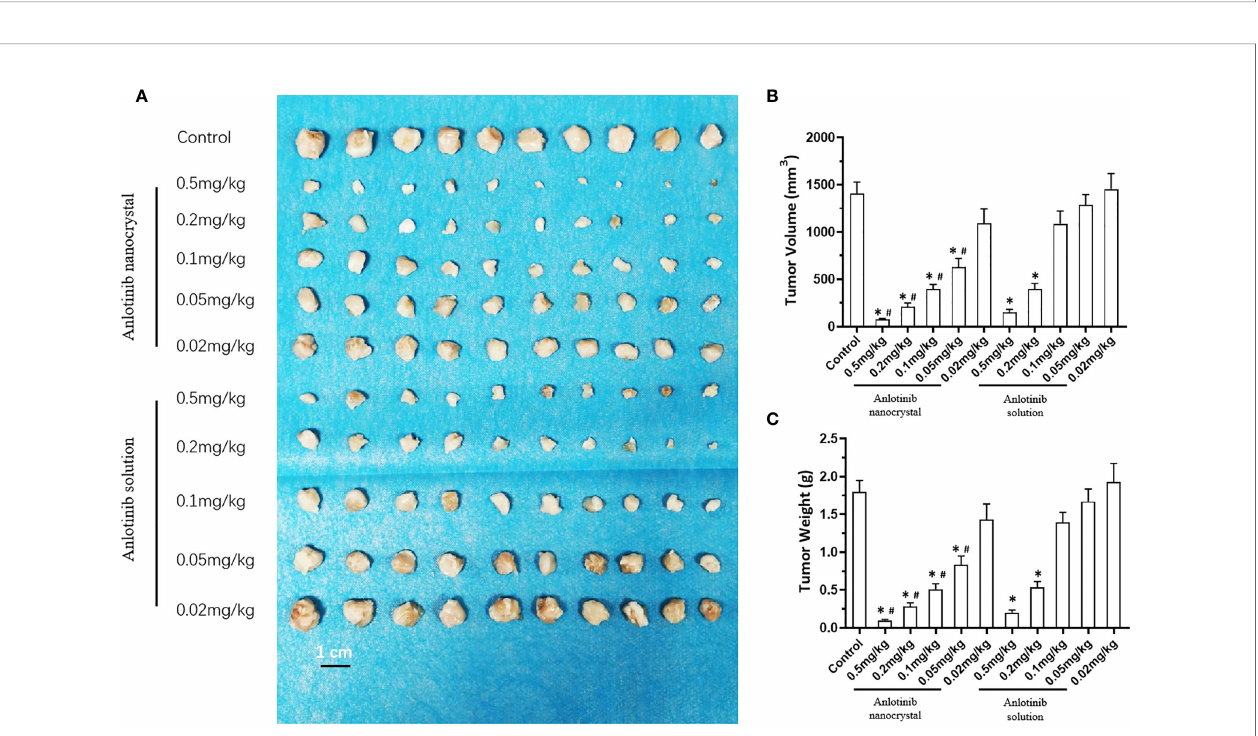
FIGURE 5 | Effect of anlotinib formulation (anlotinib solution or anlotinib nanocrystal preparation) on subcutaneous tumor formation by MHCC97-H cells. MHCC97-H cells were injected subcutaneously into nude mice to generate tumoral tissues. The mice received an intravenous anlotinib solution or the intravenous anlotinib nanocrystal preparation via the tail vein. The results are shown as tumor tissue images (A) , tumor volumes (B) , or tumor weights (C) . *P < 0.05 versus Anlotinib with control; # P < 0.05 versus Anlotinib nanocrystal with Anlotinib solution; n = 10 for every